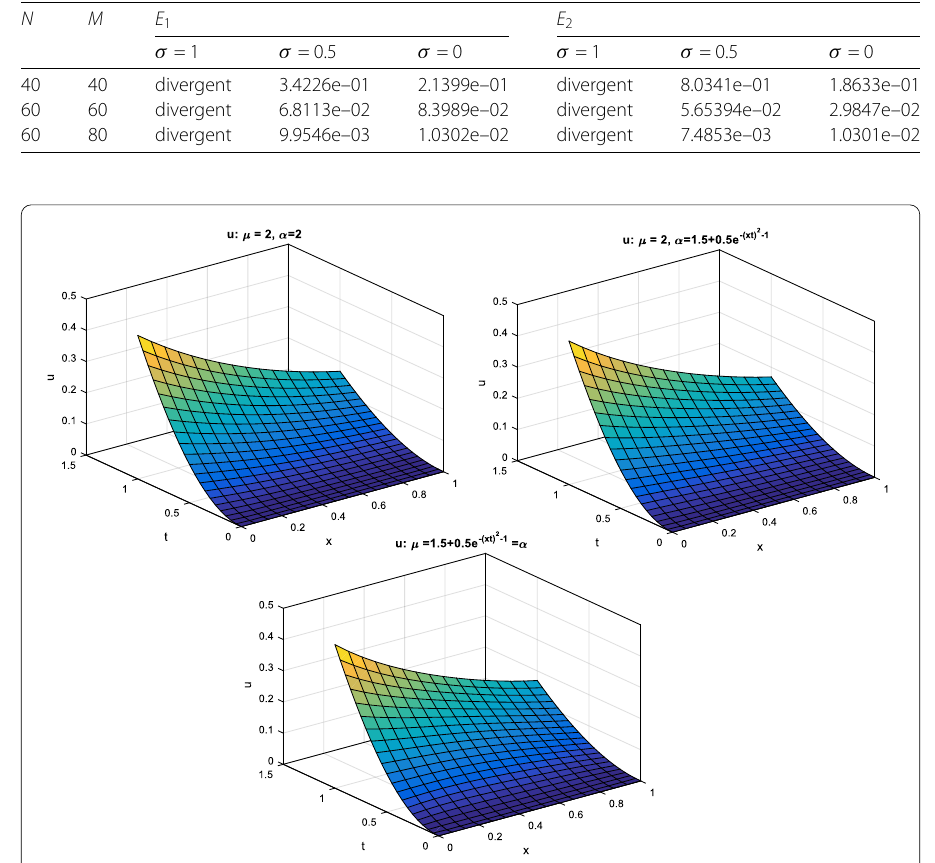
Figure 1 Comparison of the approximate solutions utilizing the introduced method in Example 1 for various values of μ ,